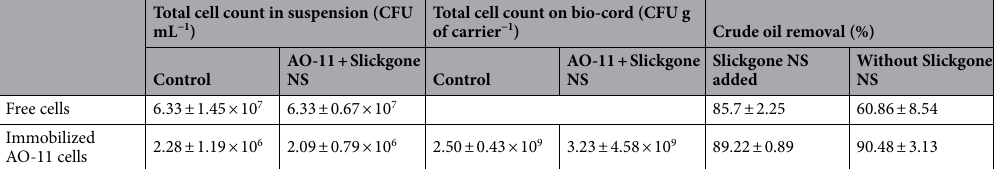
Table 2. Total viability and crude oil removal efficiency of free and immobilized Exiguobacterium sp. AO-11 after being cultured with Slickgone